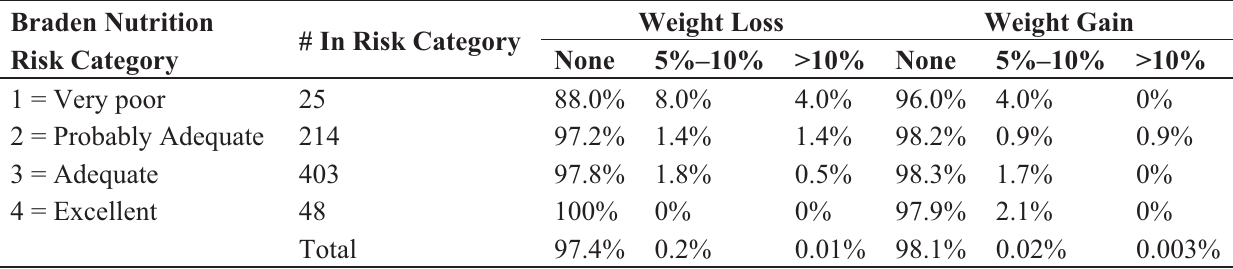
Table 4. Reported Weight Loss or Weight Gain Grouped According to Braden Nutrition Subscale Risk Categories ( n =